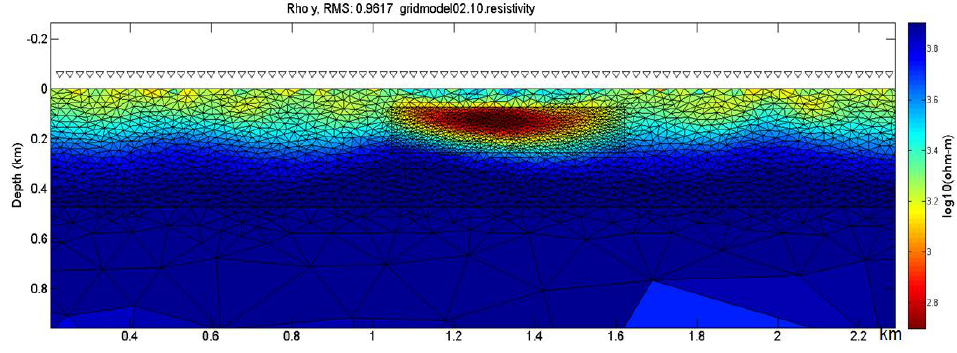
Figure 5. Resistivity-depth sections with the unstructured grid